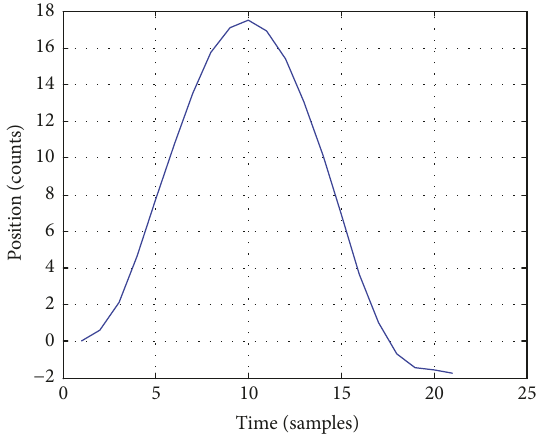
Figure 7: The position waveform of PMSM in discrete case.